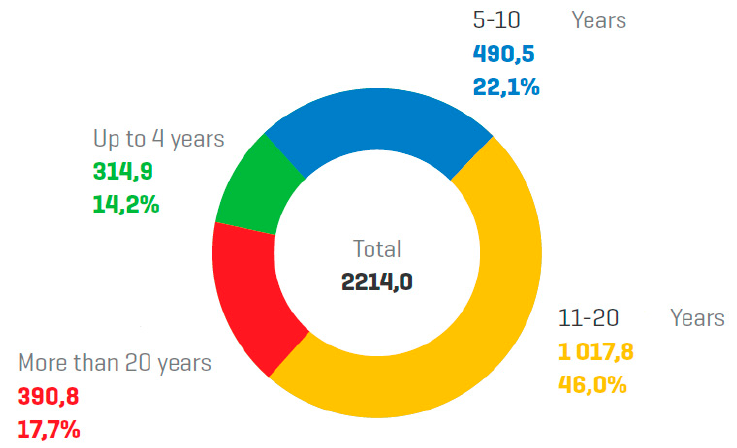
Figure 3. Age structure of commercial vehicles in Poland (up to 3.5 PGW) updated in the last 6 years in CEP (2019)